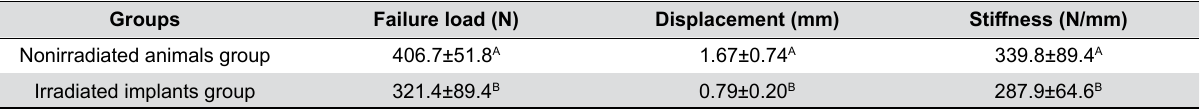
Biomechanical and morphological changes produced by ionizing radiation on bone tissue surrounding dental Table 3- Mean and standard deviation values of failure load, displacement up to the failure point and interface stiffness measured by pull- out test for nonirradiated and irradiated group